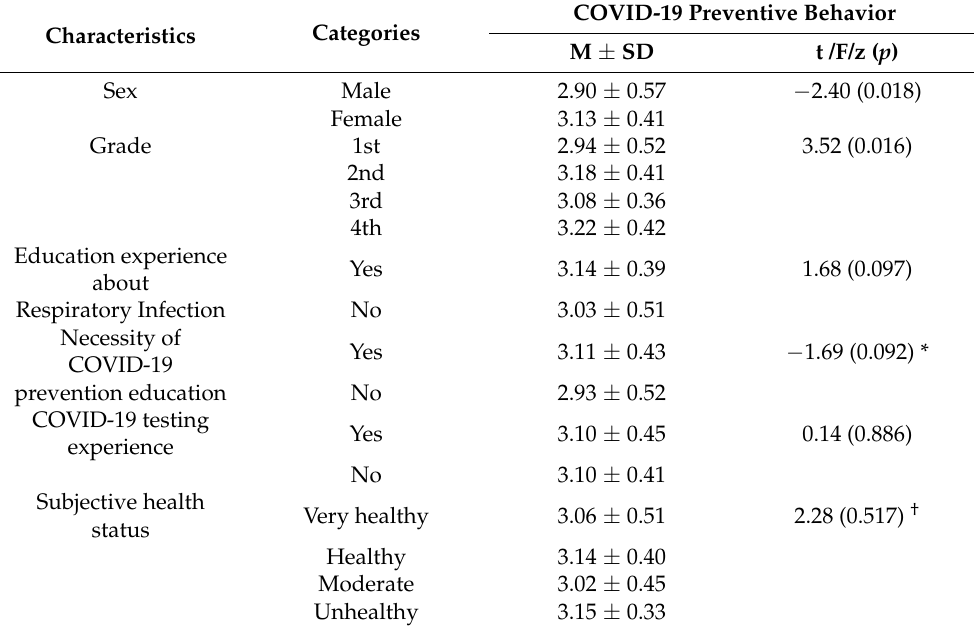
Table 3. Difference in COVID-19 preventive behavior by general